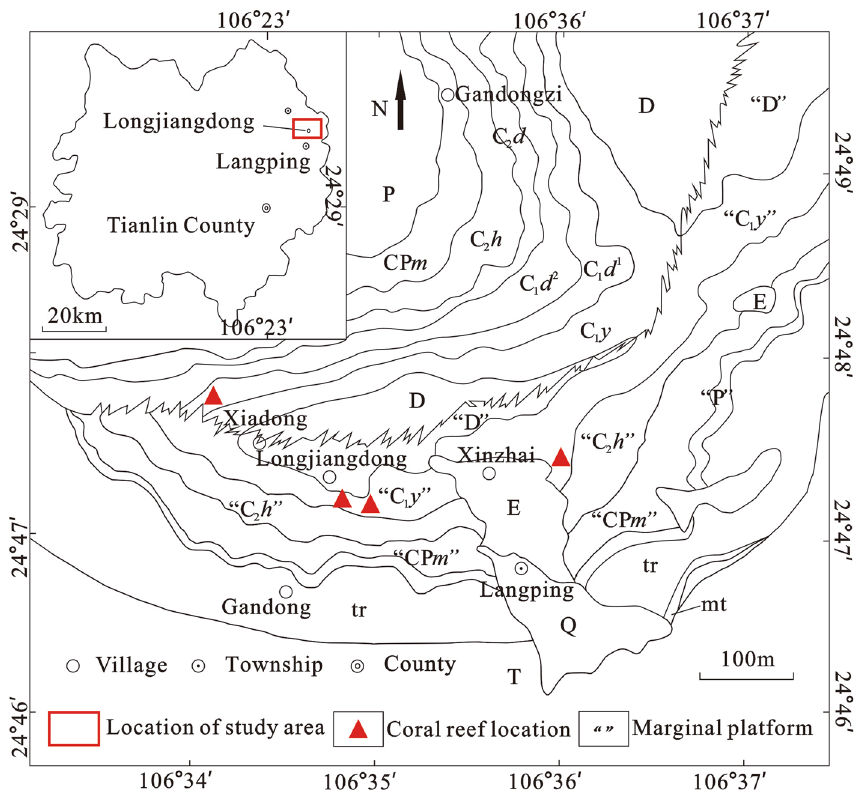
Figure 1. Geological map with coral reef outcrops in the study area. This figure was modified by the author from 1:5000 Regional Geological Survey Report by Geological Survey Institute of Guangxi Province and Administrative Map of Tianlin County. The software is CorelDRAW (vision 2022) and the URL link is https:// www. corel draw. com/